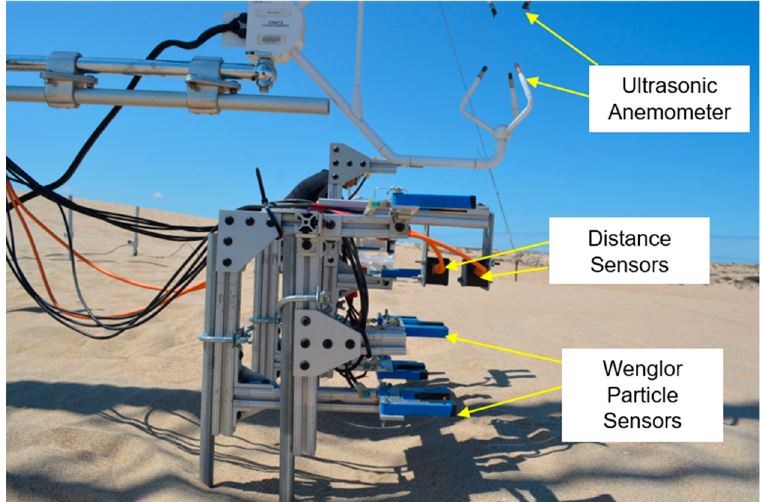
Figure 2. Configuration for ripple migration study at Oceano, USA, May–June 2015. Wind direction was right to left. The distance sensors are in the center of the photograph with orange cables.